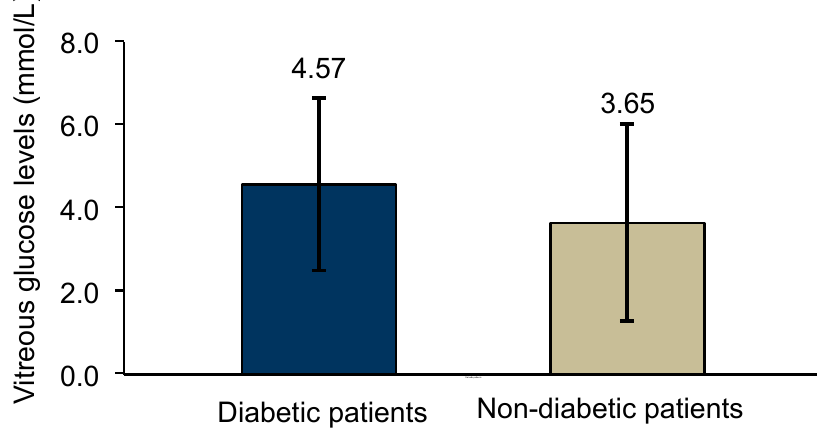
Figure 3. Comparison of glucose vitreous levels between diabetic ( n = 25) and non-diabetic control group ( n = 8) analyzed with independent-samples, t -test ( p = 0.300).